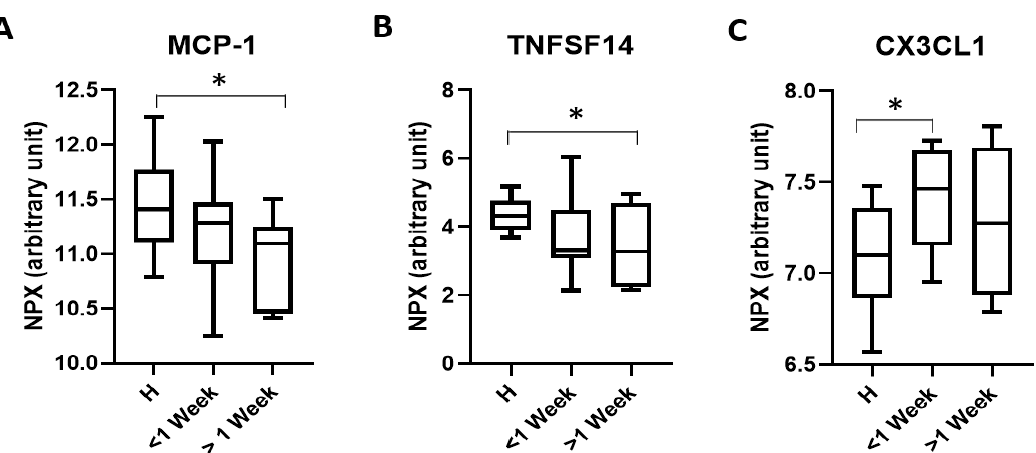
Figure 2. Changes in serum protein levels following analysis under ( < 1 week) and over a week ( > 1 week) after injury when compared to healthy (H) athletes. MCP-1 ( A ) and TNFSF14 ( B ) levels were significantly reduced in serum taken from patients > 1 week after injury. CX3CL1 ( C ) was significantly upregulated in serum taken < 1 week following injury when compared to H. Data is presented as the mean ± SE and was tested for normality followed by a one-way Anova and a tukey post hoc test where * p < 0.05. H = 12, < 1 week = 11, > 1 week = 7.